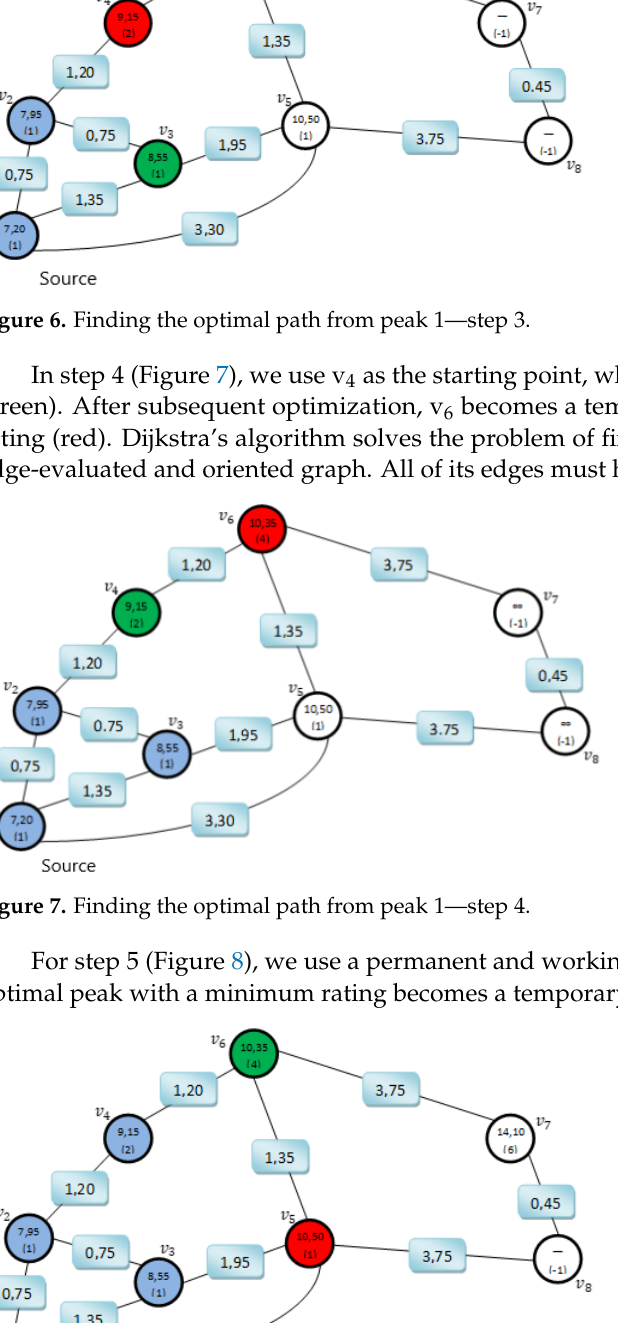
Figure 9. Finding the optimal path from peak 1—step 6. We repeated the procedure for step 7 (Figure 10), for which we used a permanent and working peak v 7 (green), in which the optimal peak with a minimum rating became a temporary peak v 8 (red). Figure 10. Finding the optimal path from peak 1—step 7.